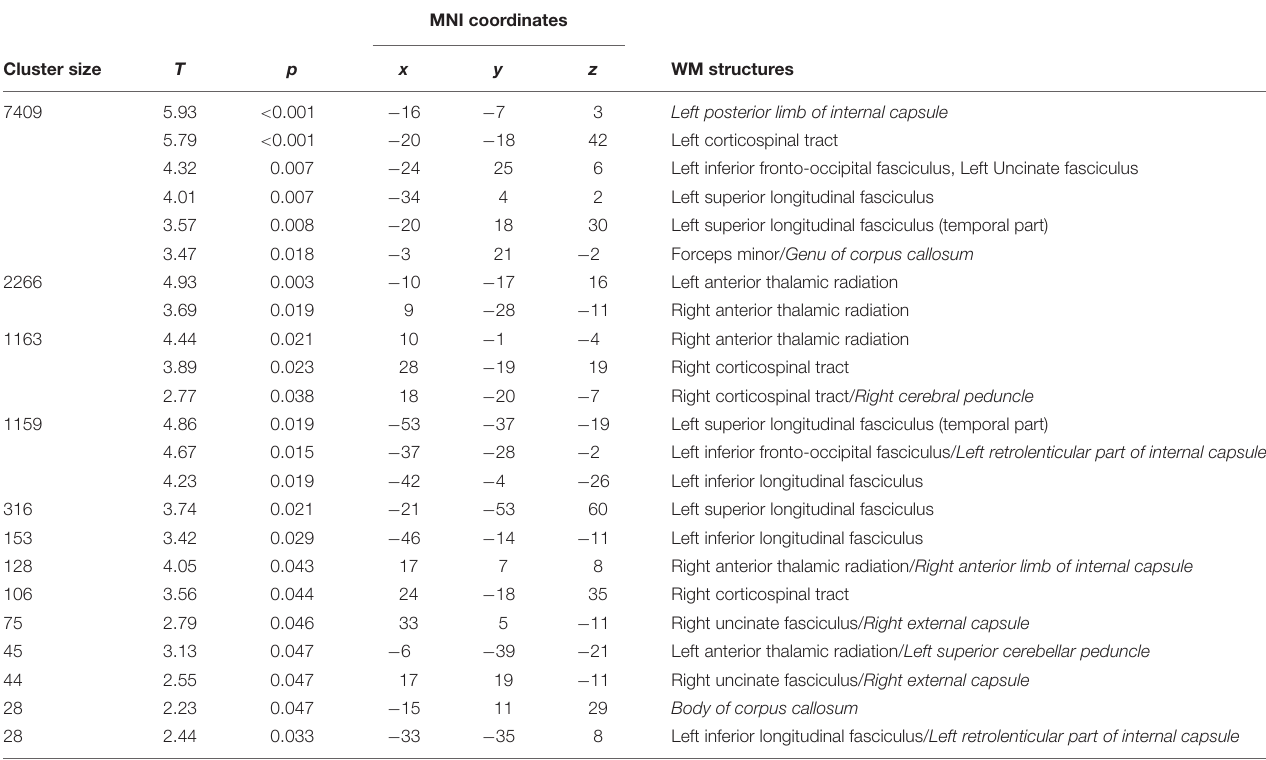
TABLE 2 | Significant increases in FA at T1 respect to T0 (pFWE < 0.05